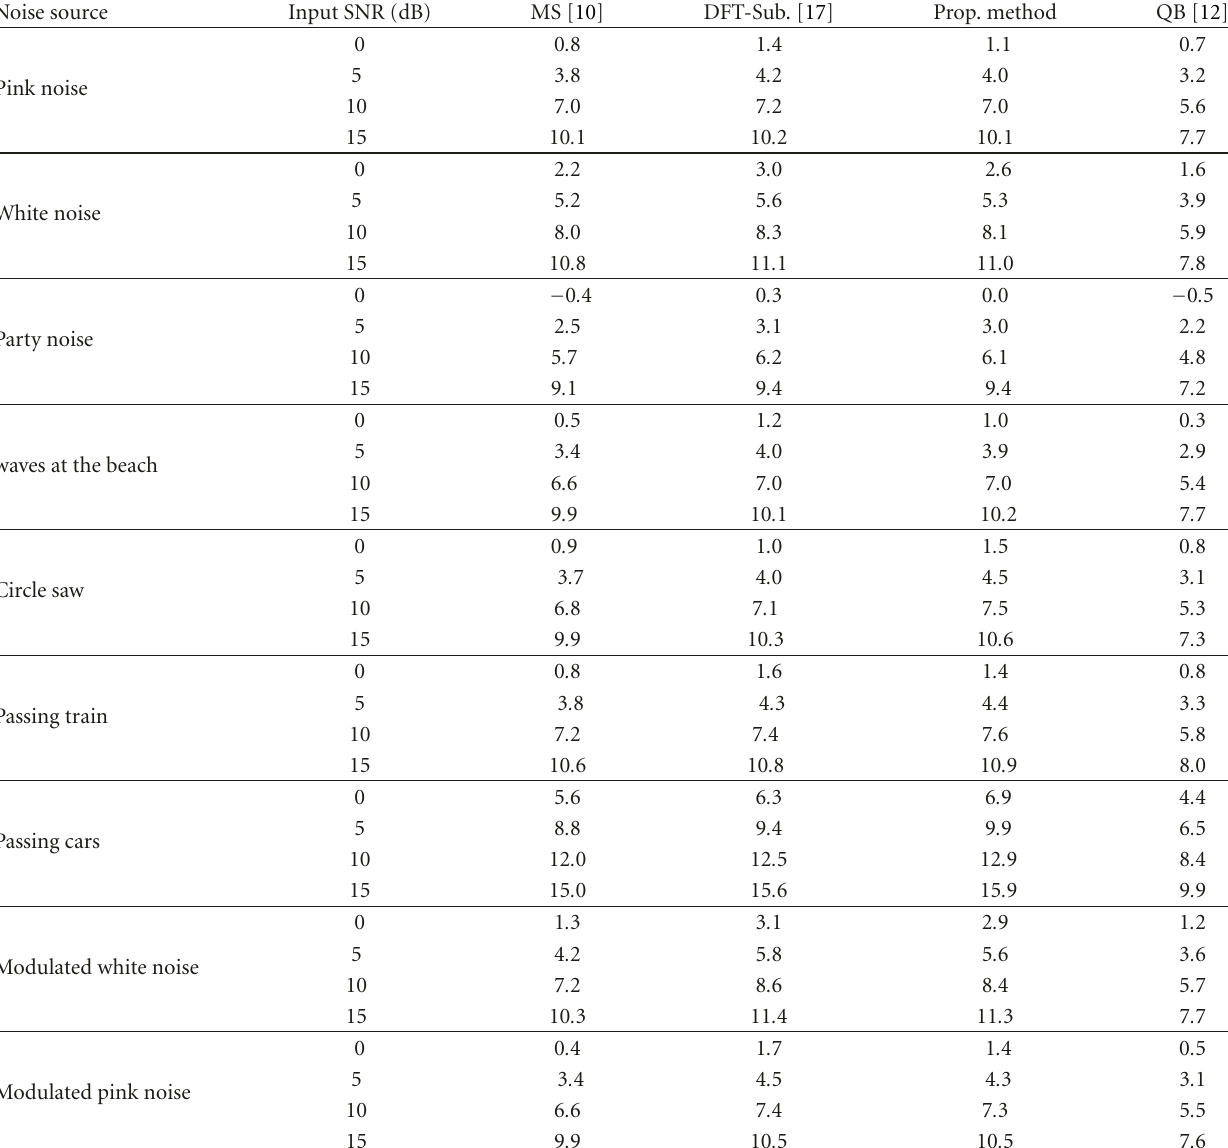
Table 3: Performance in terms of SNR seg